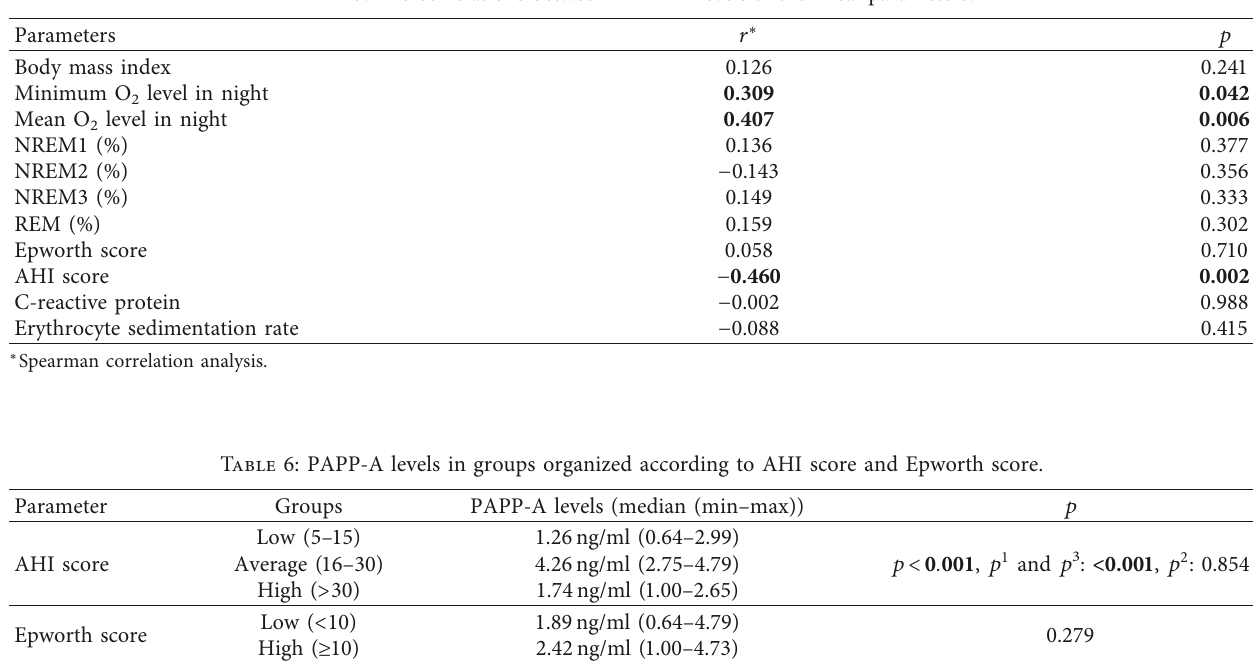
Table 5: The correlations between PAPP-A levels and clinical parameters.